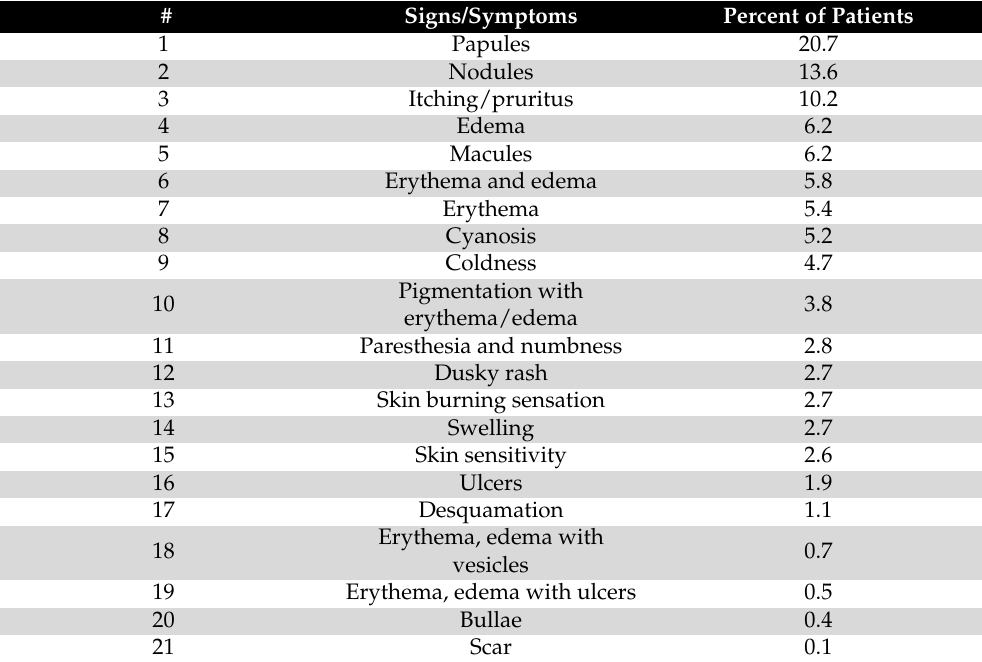
Table 2. Prevalence of chilblains signs and